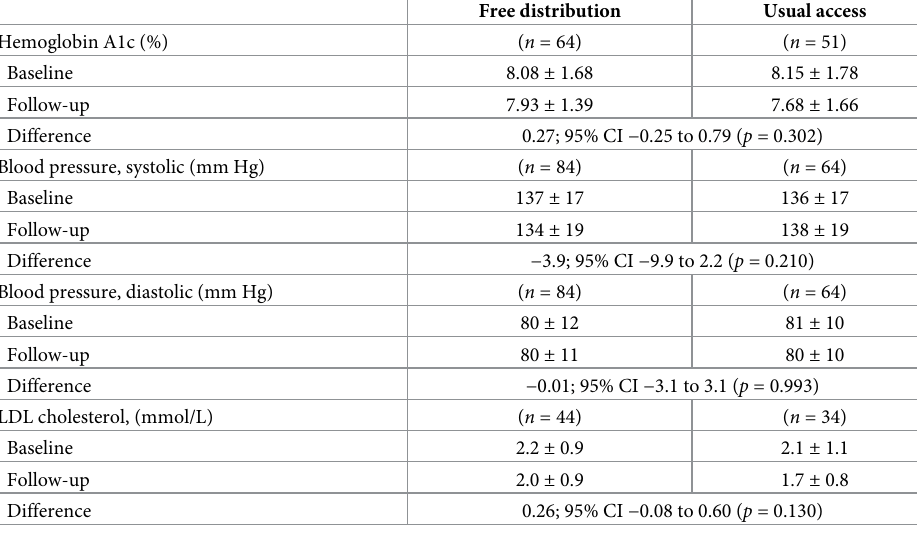
Table 3. Secondary surrogate health outcome results by group after 2